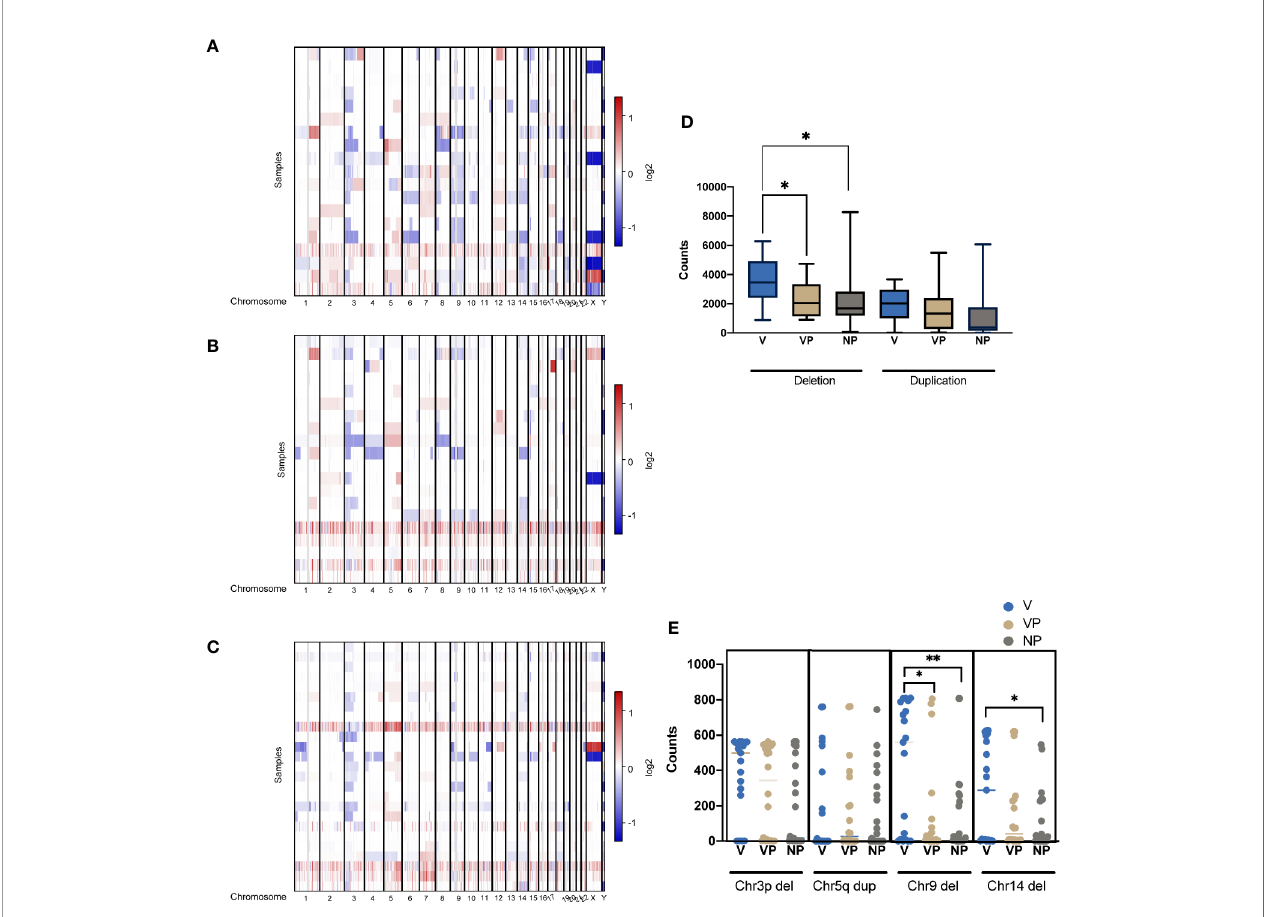
FIGURE 5 | CNVs of tumors were plotted by chromosomal location (vertical axis) of the entire dataset in the V (A) , VP (B) , and NP groups (C) . (D) Differences in the copy number deletions and duplications in the three groups. (E) The counts of deletion of chromosome 3p (Chr3p Del), duplication of chromosome 5q (Chr5q Dup), deletions of chromosome 9 (Chr9 Del) and chromosome 14 in the three groups. * p < 0.05; ** p < 0.01. CNV, copy number variation; VTT, venous tumor thrombus; V, VTT; VP, VTT matched primary tumor; NP, normal primary tumors without